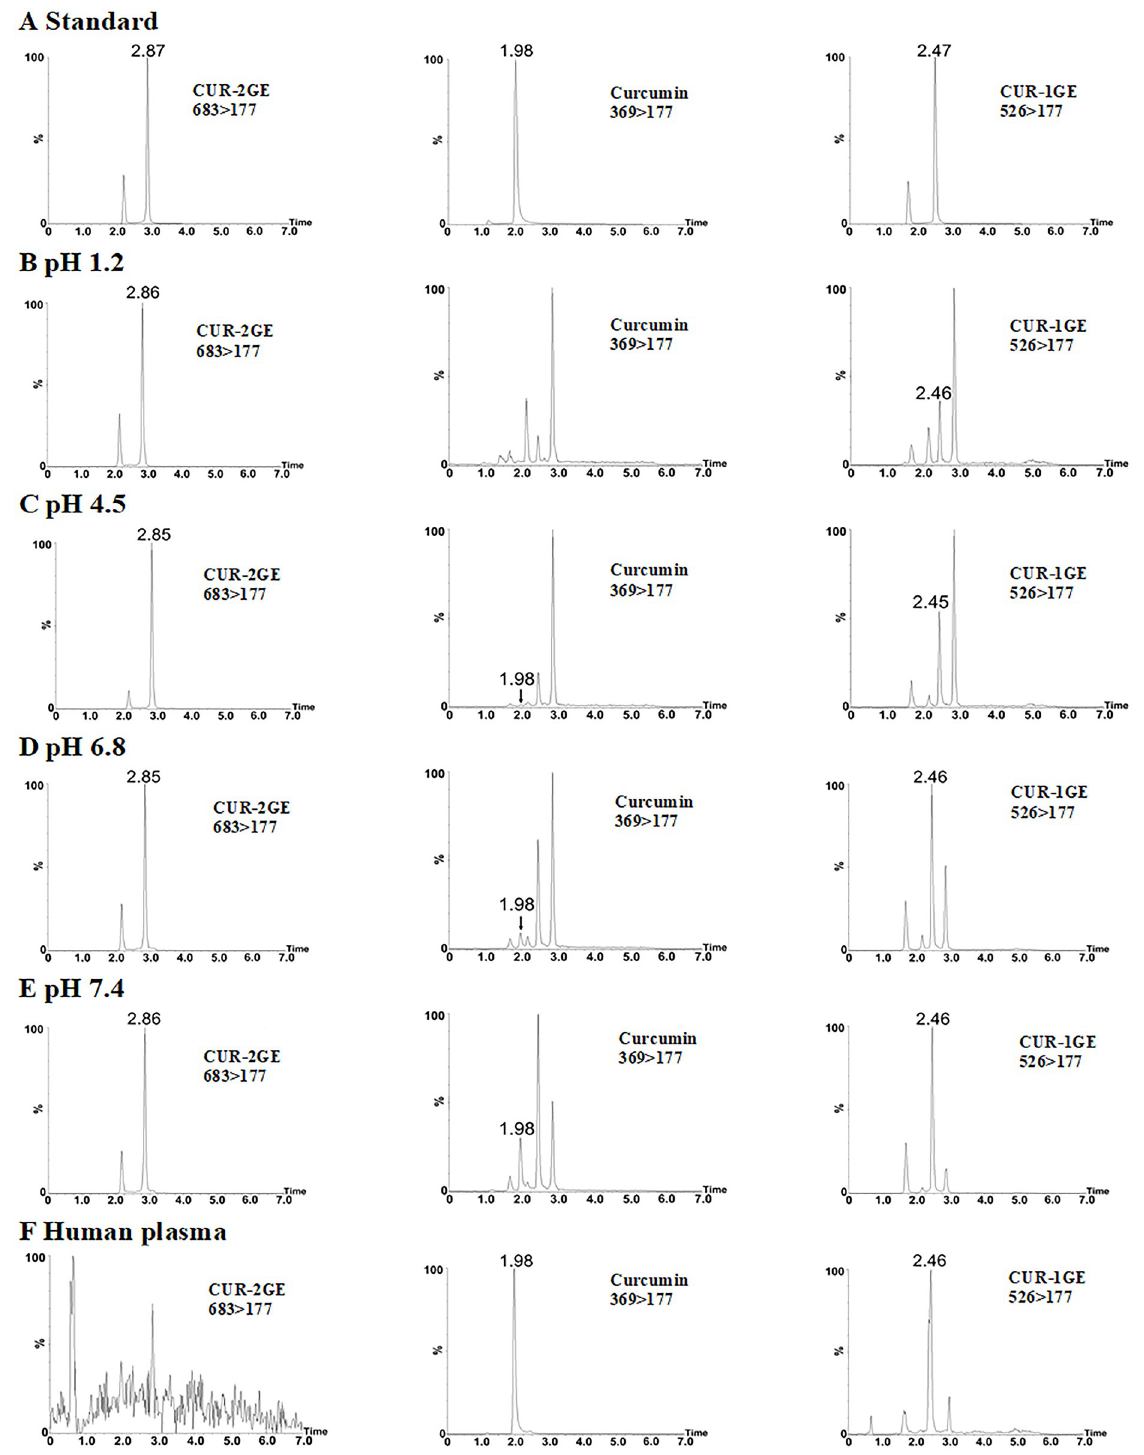
Fig 6. UPLC-MS/MS chromatograms of CUR-2GE, curcumin, CUR-1GE. (A) CUR-2GE, curcumin and CUR-1GE standards at 10 μ g/mL, CUR-2GE incubated at 37˚C in buffers at (B) pH 1.2 for 24 h, (C) pH 4.5 for 24 h, (D) pH 6.8 for 7 min, (E) pH 7.4 for 7 min and (F) human plasma for 1 h. The peak of CUR-2GE, curcumin and CUR-1GE was shown at the retention times about 2.87, 1.98 and 2.47, respectively. The peak with retention times of 2.18 and 1.69 min represented tautomers of CUR-2GE and CUR-1GE, respectively, as they exhibited the same transition ions. Other peaks were generated from an insource